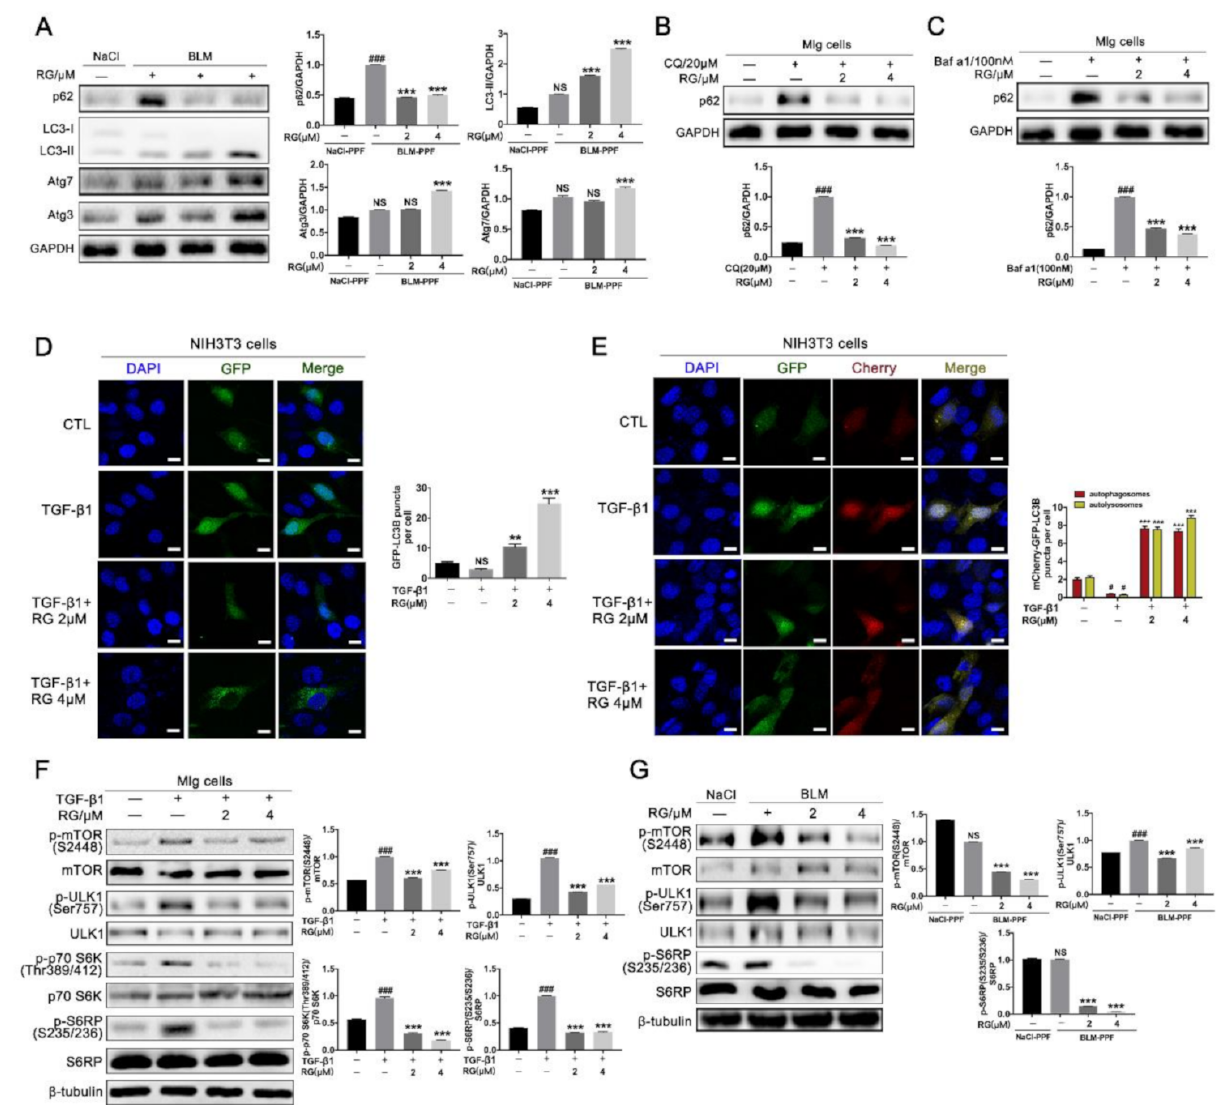
Figure 4. Regorafenib induces the formation of autophagy by inhibiting the TGF- β 1/mTOR signal pathway. ( A ) BLM-PPF cells were treated with RG (2 µ M, 4 µ M) for 24 h, and the expression levels of autophagy-related proteins (Atg3, Atg7, p62, and LC3-II/I) were detected. Densitometric analysis are shown beside; ( B ) Mlg cells were exposed to chloroquine (CQ) and/or RG (2 µ M, 4 µ M) for 24 h, and Western blot technology was used to detect the p62 protein expression level; ( C ) Mlg cells were exposed to bafilomycin A1 (Baf A1) and/or RG (2 µ M, 4 µ M) for 24 h. Densitometric analysis are shown below; ( D , E ) The plasmids of GFP-LC3B (green fluorescent protein-microtubule-associated protein 1 light chain 3B) and mCherry-GFP-LC3B (mCherry fluorescent protein-green fluorescent protein-microtubule-associated protein 1 light chain 3B) was transferred into NIH-3T3 cells, and these cells subsequently were incubated with RG (2 µ M, 4 µ M) and/or TGF- β 1 (5 ng/mL) for 12 h. DNA was counterstained with DAPI (blue). Scale bars: 50 µ m; ( F ) Mlg cells were incubated with RG (2 µ M, 4 µ M) and/or TGF- β 1 (5 ng/mL) for 12 h, and the expression levels of mTOR (mechanistic target of rapamycin), ULK-1 (protein kinase ULK1/autophagy-related protein 1), p70 S6K (p70 S6 kinase), and S6RP (S6 ribosomal protein), and their phosphorylations were detected. Densitometric analysis are shown beside; ( G ) BLM-PPF cells were explored to RG (2 µ M, 4 µ M) for 12 h, and Western Blot were used to detect the expression levels of mTOR, ULK-1, and S6RP, and their phosphorylations. Densitometric analysis are shown beside. Data in ( A – G ) are means ± standard error of mean (SEM), and GAPDH or β -tubulin were used as a loading control. # p < 0.05, ### p < 0.001, ** p < 0.01, *** p < 0.001(one-way ANOVA). NS: not